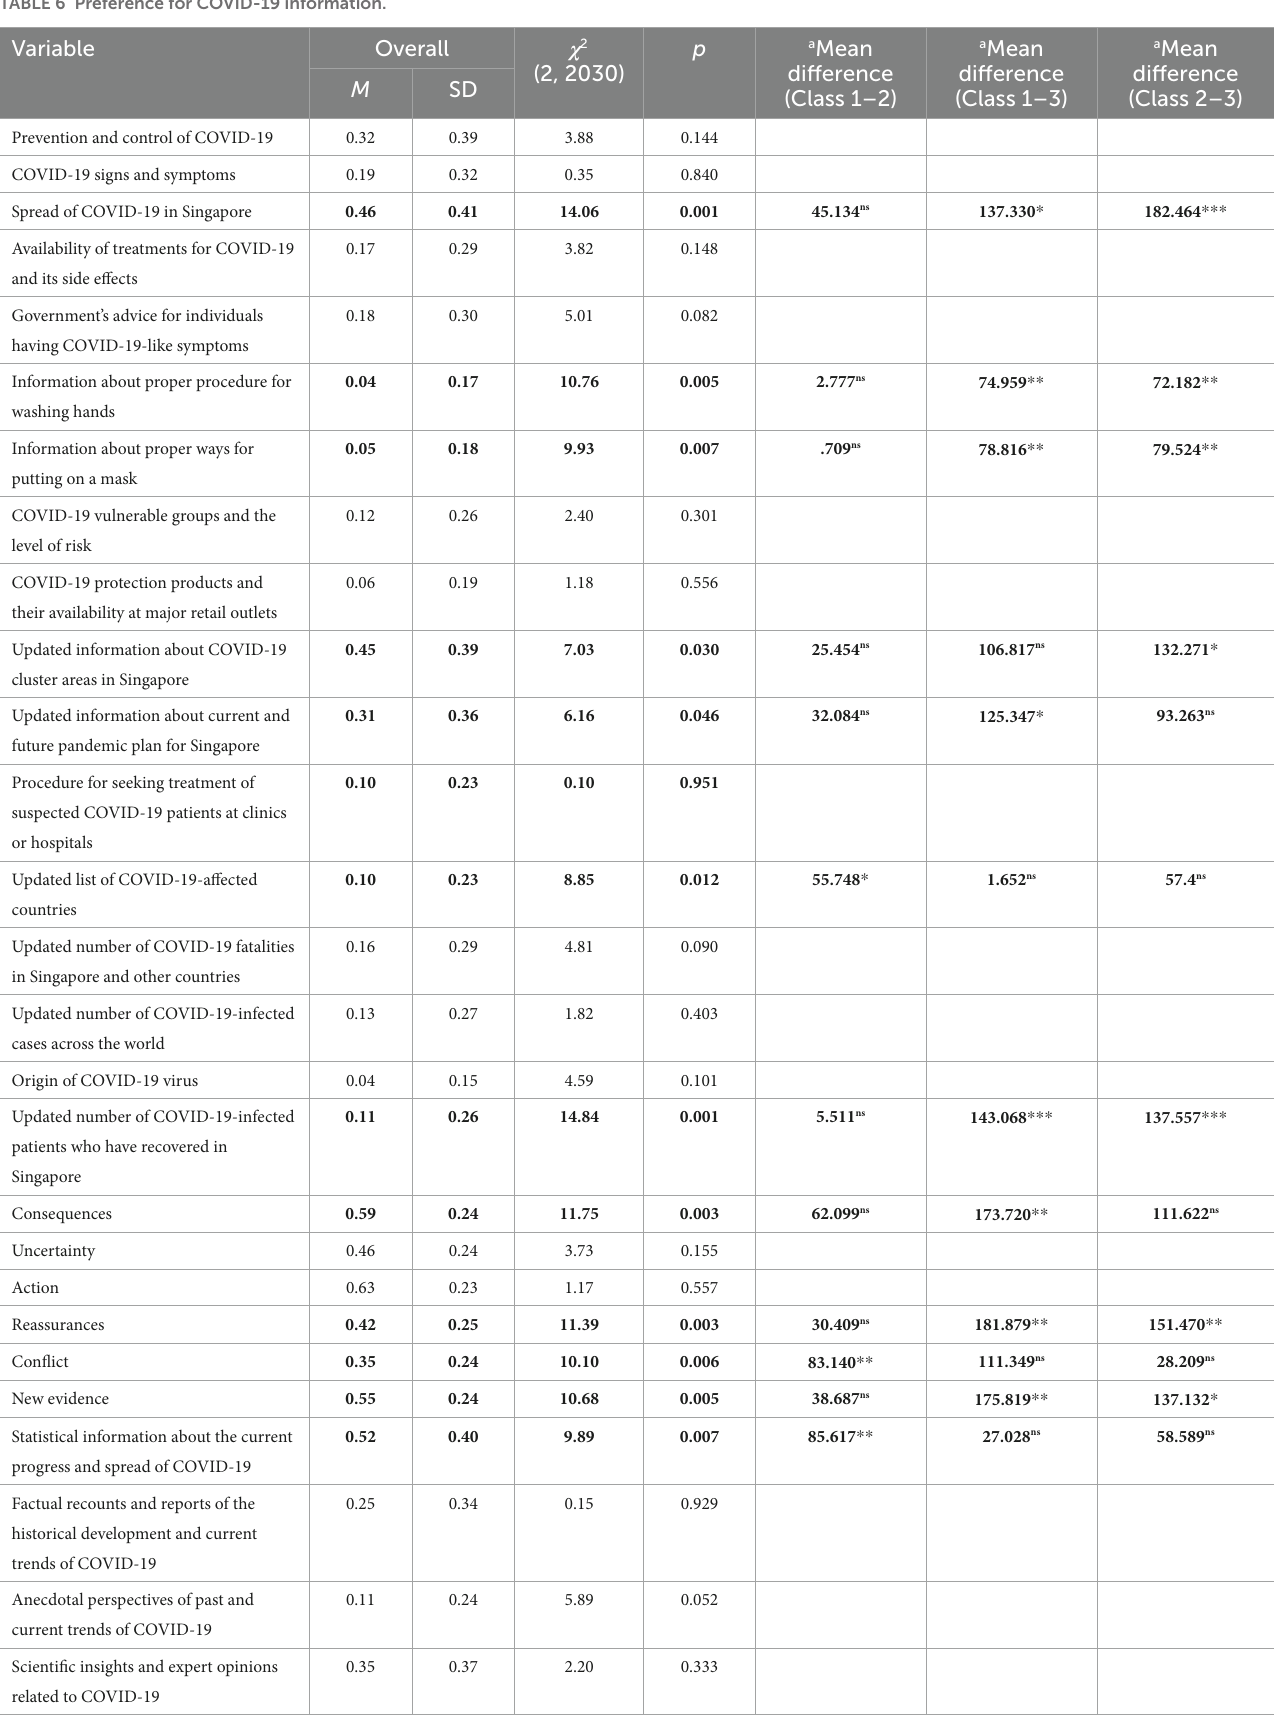
TABLE 6 Preference for COVID-19